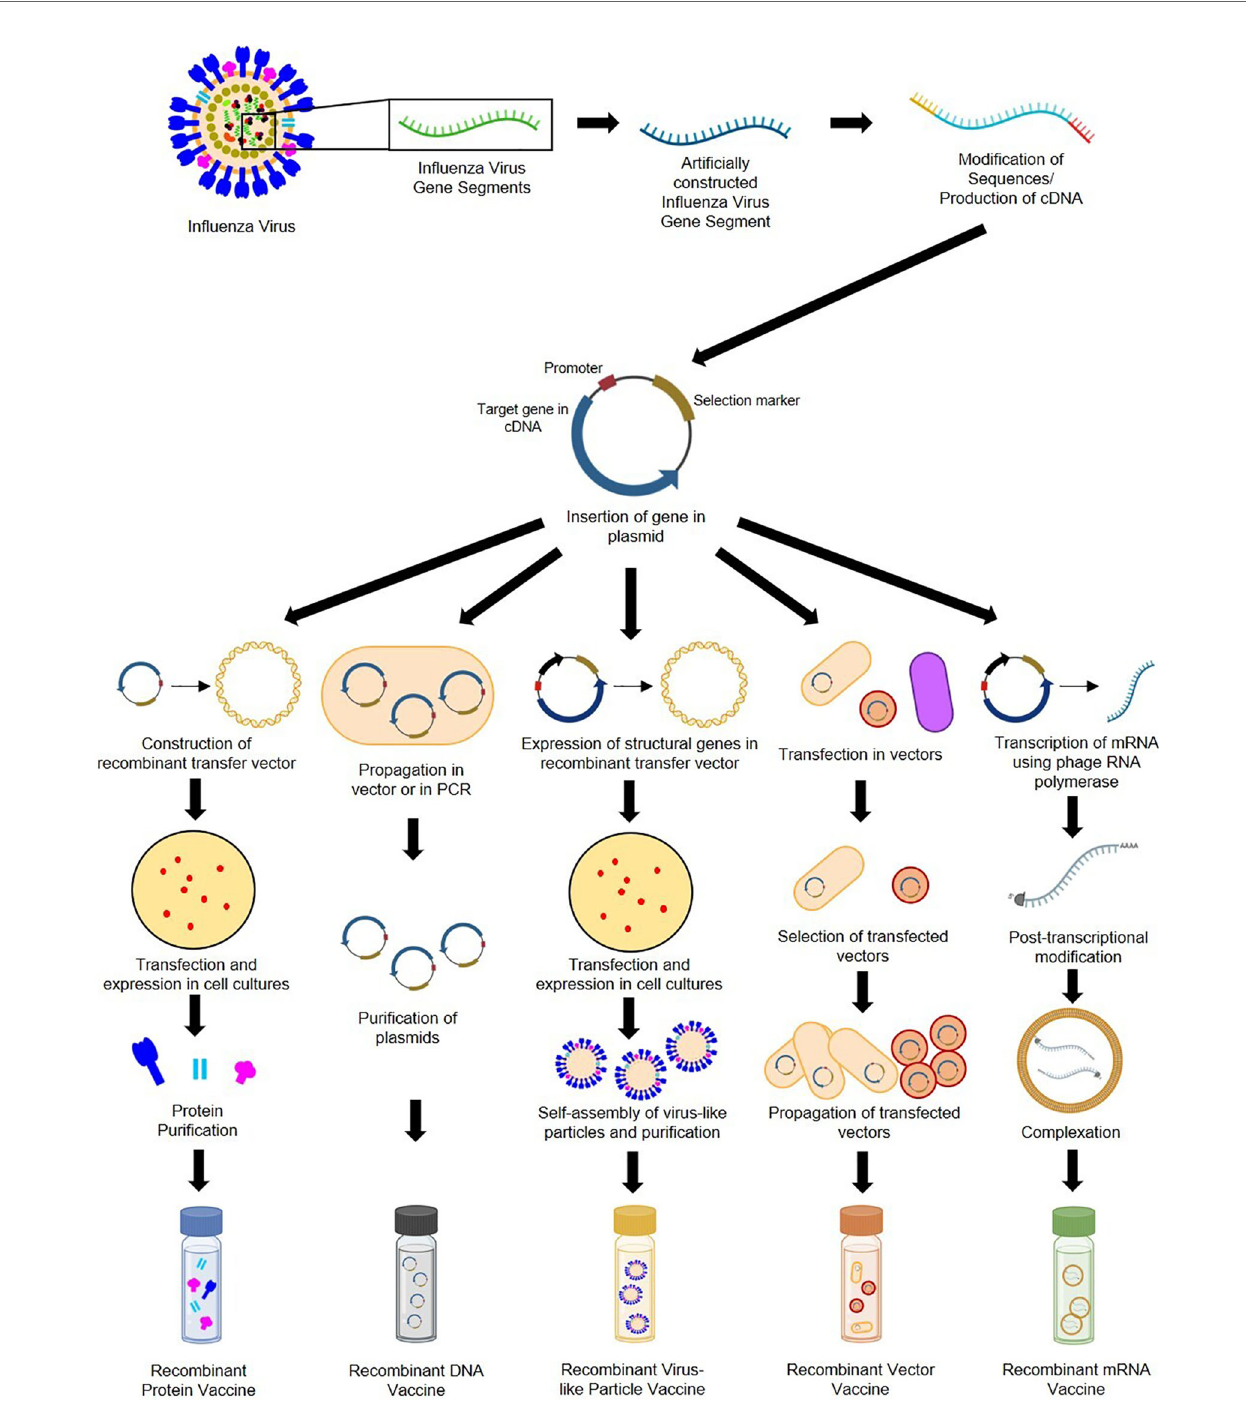
FIGURE 4 | General construction process of recombinant protein, DNA, VLP, vector-based, and mRNA in fl uenza